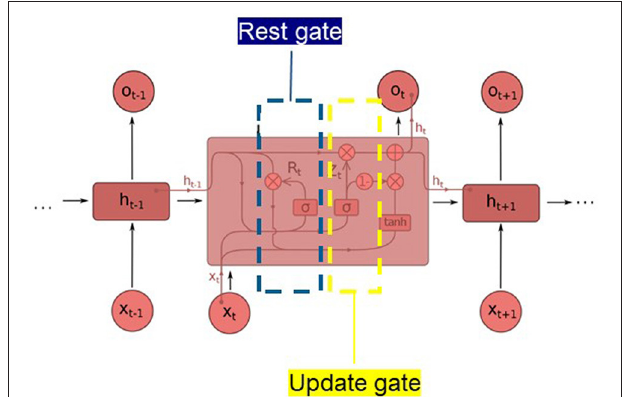
FIGURE 7 | Structure of GRU.